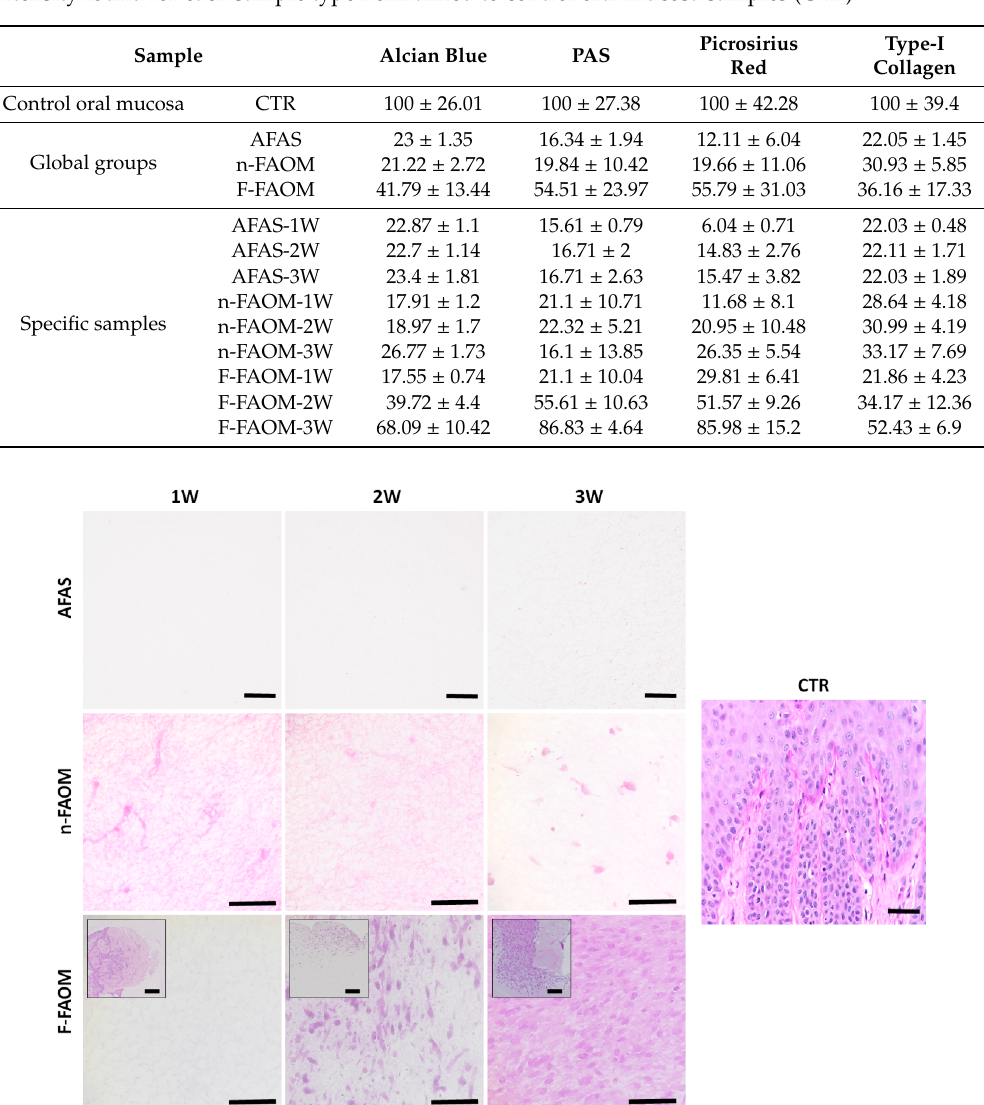
Figure 4. Histochemical analysis of controls and biofabricated oral tissues using PAS staining. CTR: